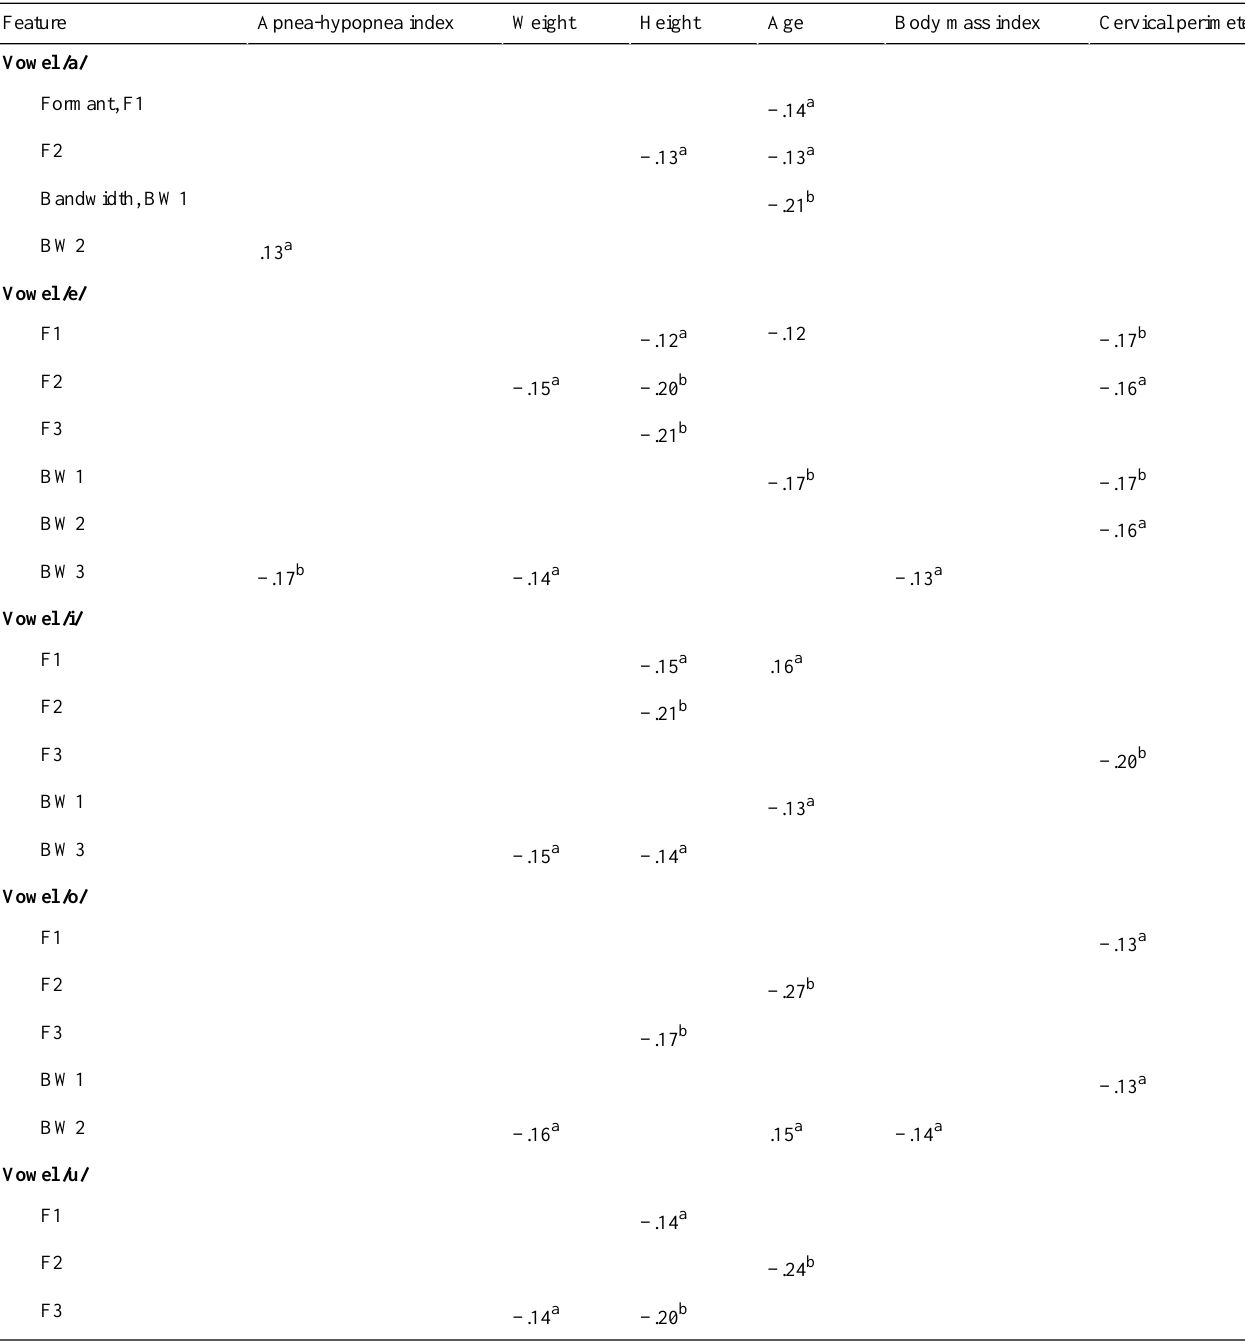
Table 5. Statistically significant Spearman correlation between formant frequencies and clinical variables on the male (n=241) population (for clarity, nonsignificant correlation values are